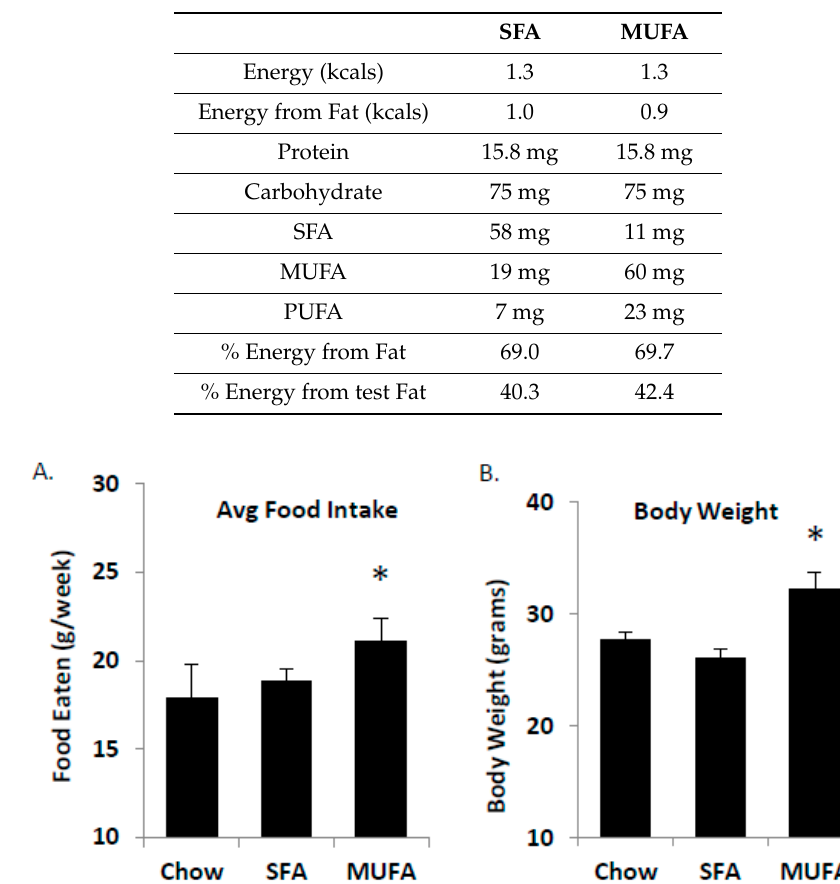
Table 1. Composition of fat-enriched test meals.